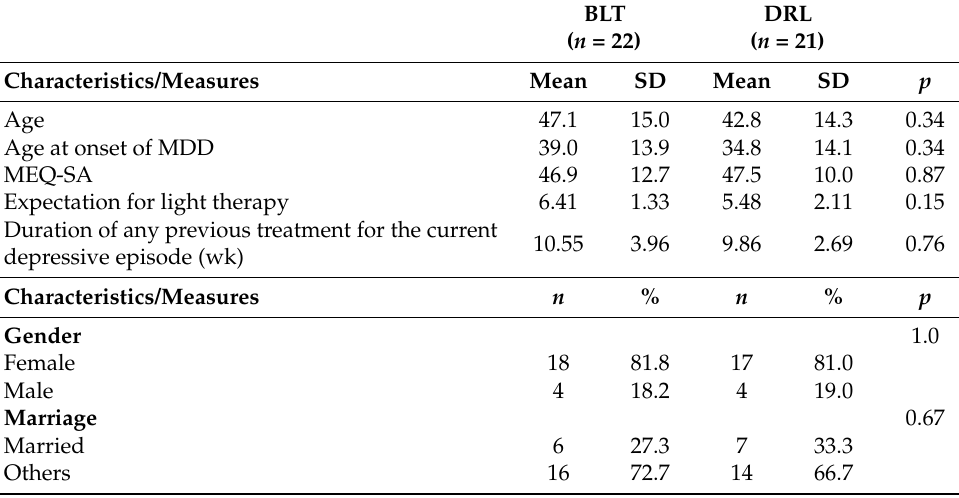
Figure 1. Participant flow diagram through the entire study. BLT: bright light therapy; DRL: dim red light; HAMD-17: Hamilton Depression Rating Scale-17 items. Table 1. Demographic characteristics and clinical measures at baseline.